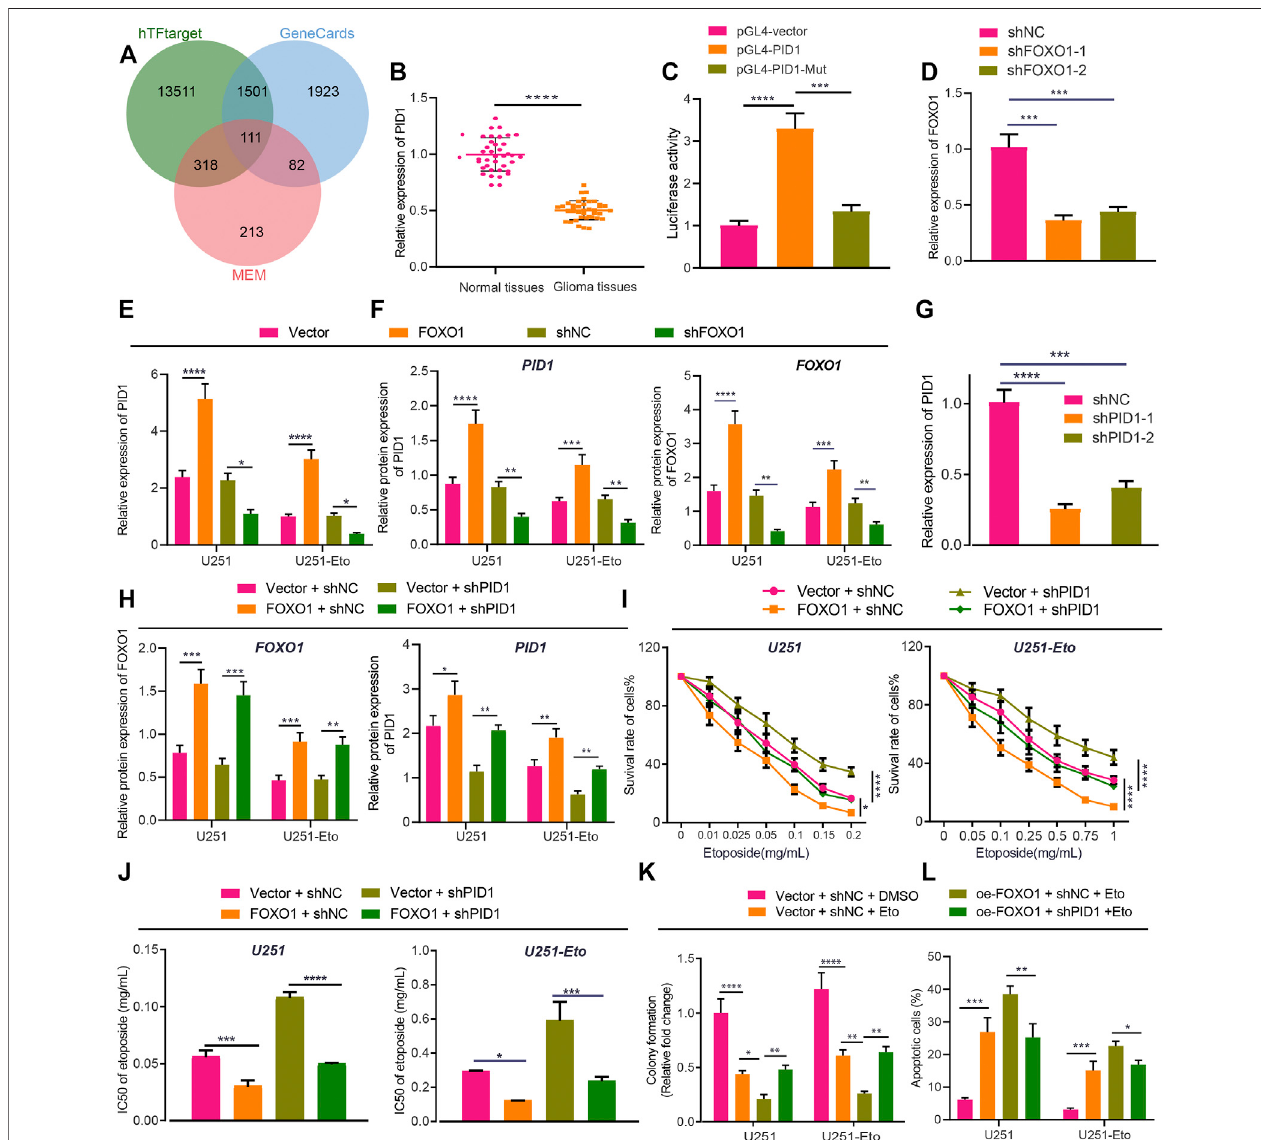
FIGURE6| FOXO1increasessensitivityofGBMcellstoetoposidechemotherapythroughPID1promotion. (A) VenndiagramofFOXO1relatedgenes,targetgenes and glioma genes screened from the hTFtarget website, MEM and GeneCards dataset. (B) RT-qPCR analysis of PID1 mRNA expression in clinical glioma tissues and normalbraintissues. (C) Luciferaseactivity of PID1in U251cellsupontreatment withFOXO1 plasmids determined by dual-luciferasereporter geneassay. (D) RT-qPCR analysis of ef fi ciency of PID1 silencing in U251 and U251-Eto cells upon treatment with sh-FOXO1-1 or sh-FOXO1-2. (E) RT-qPCR analysis of PID1 mRNA expression in U251 and U251-Eto cells upon treatment with FOXO1, sh-FOXO1, sh-NC, or vector. (F) Western blot analysis of PID1 and FOXO1 proteins in U251 and U251-Eto cells upon treatment with FOXO1, sh-FOXO1, sh-NC, or vector. (G) RT-qPCR analysis of ef fi ciency of PID1 silencing in U251 and U251-Eto cells upon treatmentwithsh-PID1-1orsh-PID1-2. (H) WesternblotanalysisofPID1andFOXO1proteinsinU251andU251-Etocellsupontreatmentwithvector +sh-NC,vector+ sh-PID1,FOXO1+sh-NC,orFOXO1+sh-PID1. (I) MTTanalysisofU251andU251-Etocellviabilityupontreatmentwithvector+sh-NC,vector+sh-PID1,FOXO1+sh- NC,orFOXO1+sh-PID1. (J) IC 50 ofetoposideinU251andU251-Etocellsupontreatmentwithvector+sh-NC,vector+sh-PID1,FOXO1+sh-NC,orFOXO1+sh-PID1. (K) Quanti fi cation ofcolonyformationassayon U251and U251-Etocellsupontreatment withvector+ sh-NC,vector+ sh-PID1, FOXO1+ sh-NC,or FOXO1 + sh-PID1. (L) FlowcytometricanalysisofU251andU251-EtocellapoptosisupontreatmentwithFOXO1,DANCR,FOXO1+DANCR,orvector.InpanelA – G,* p < 0.05,** p < 0.01, *** p < 0.001, **** p < 0.0001. In panel H – L, * p < 0.05, ** p < 0.01, *** p < 0.001, **** p < 0.0001. Values shown represent mean ± standard deviation of three independently performed experiments. Data between two groups were compared by unpaired t test. Multigroup data comparison was conducted by one-way ANOVA followed by Tukey post hoc test. Data among groups at different concentrations were compared by two-way ANOVA, followed by Tukey post hoc test.